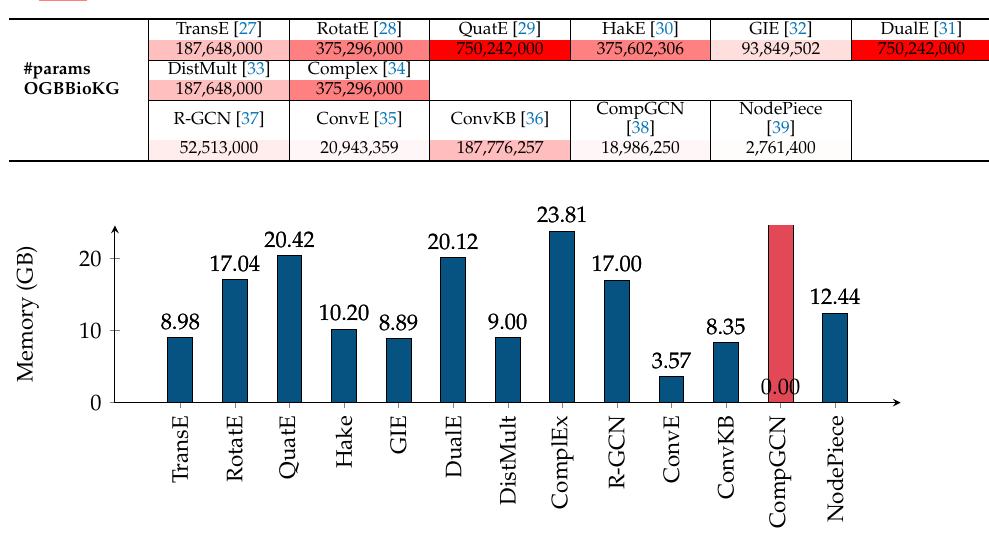
Figure 9. Training and evaluation times (stacked) for each model on OGB-BioKG. Table 9. Number of parameters of each model on OGBBioKG. Top: translational models. Center: se- mantic matching models. Bottom: neural network-based models. The architectural cost is highlighted by red gradients (the deeper, the greater).